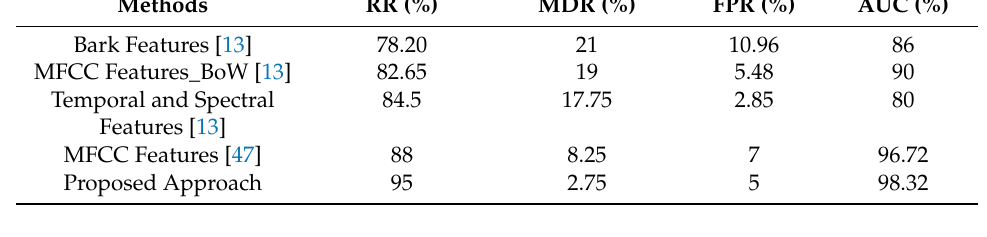
Table 5. Comparison of performance results between the proposed approach and other approaches.